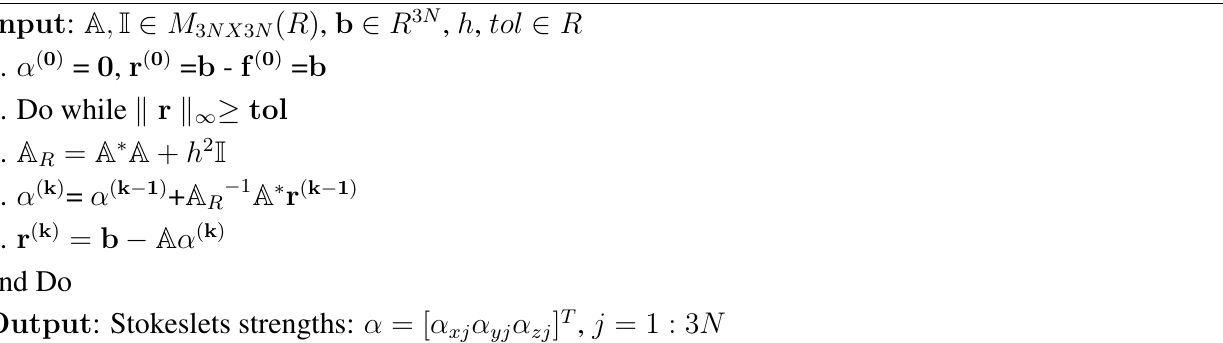
Algorithm 1 Algorithm for finding the strengths of each Stokeslet-source